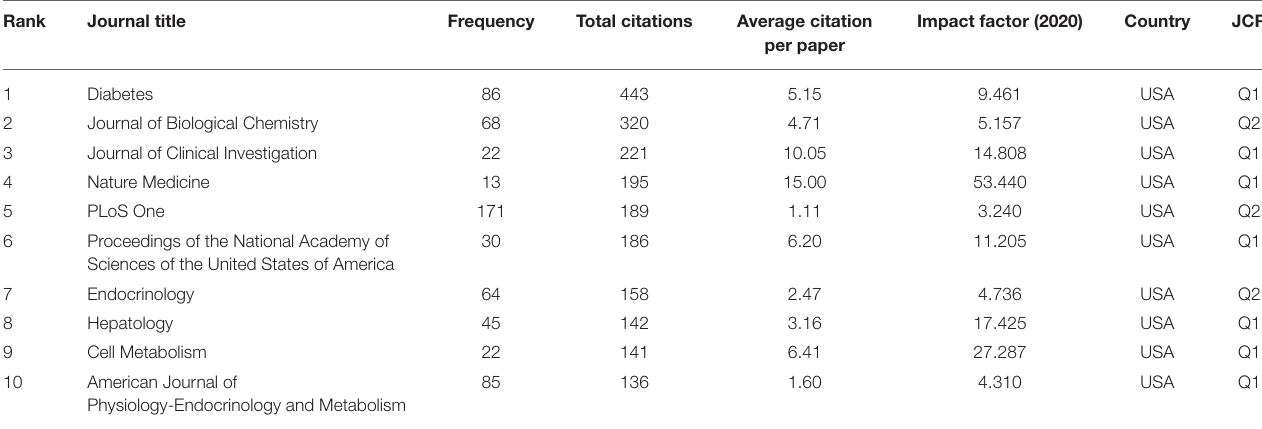
TABLE 1 | The top 10 most active journals that published articles in hepatic glucolipid metabolism research (sorted by total citation).